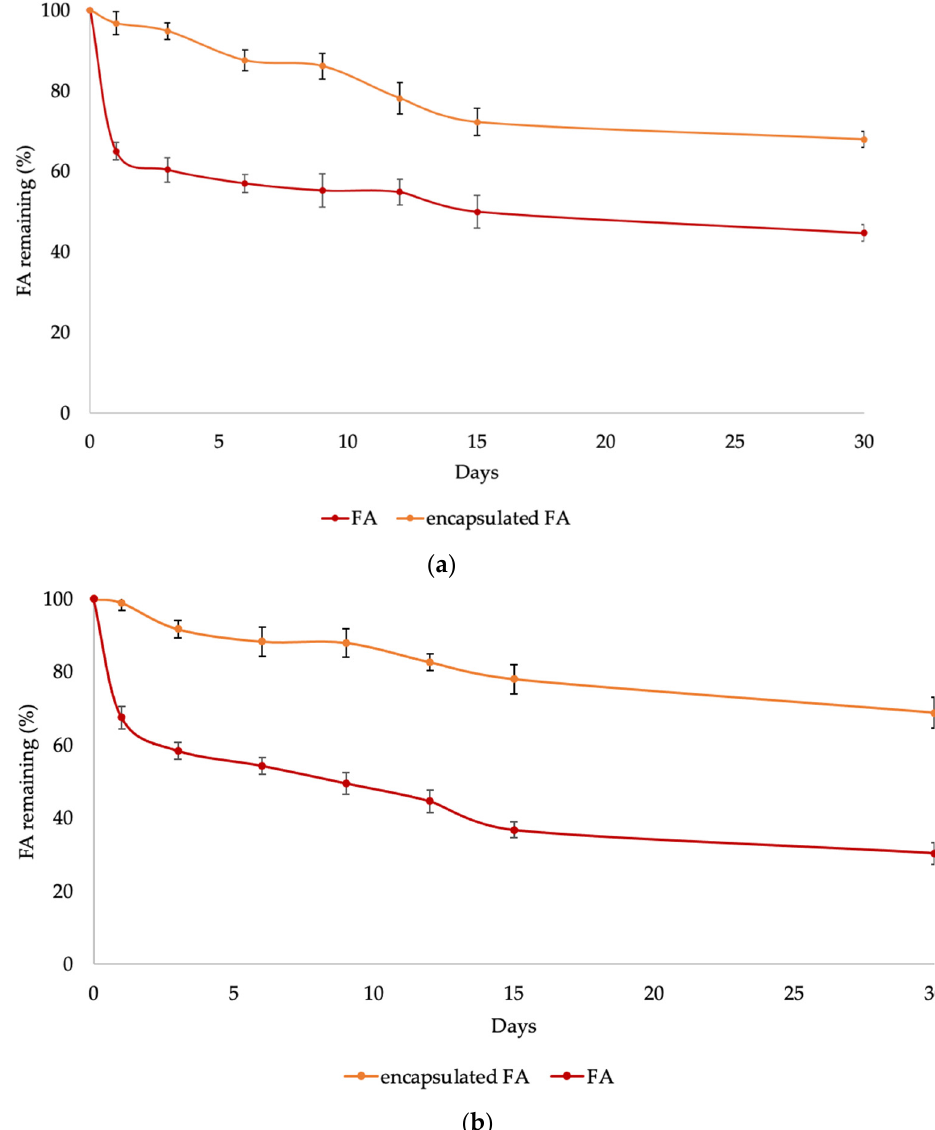
Figure 5. Stability of encapsulated FA and FA storage at high temperature, 80% RH ( a ) and light exposure ( b ) .